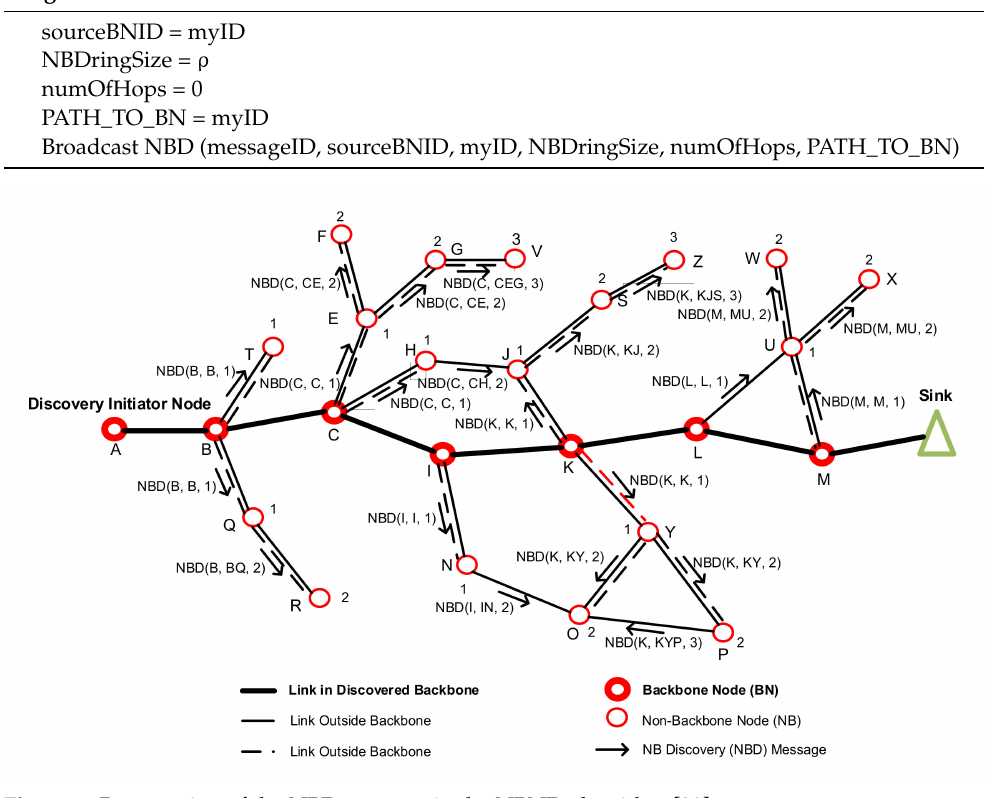
Figure 3. Propagation of the NBD message in the NBND algorithm [39]. Table 2. Main notations used in the NBND